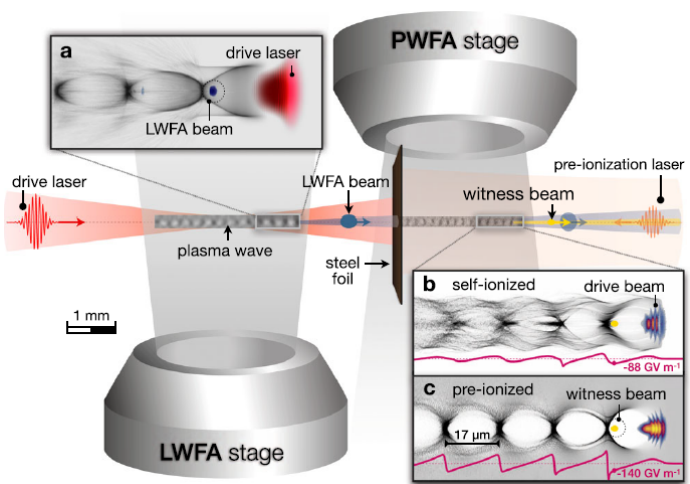
Figure 9. Hybrid LWFA → PWFA platform and driver/witness-type PWFA, using two separate gas jets and three laser arms to drive the LWFA stage and pre-ionize the PWFA stage for shadowgraphy imaging (figure adapted from [48]). The insets show simulation representations of LWFA and self- ionized and pre-ionized PWFA,